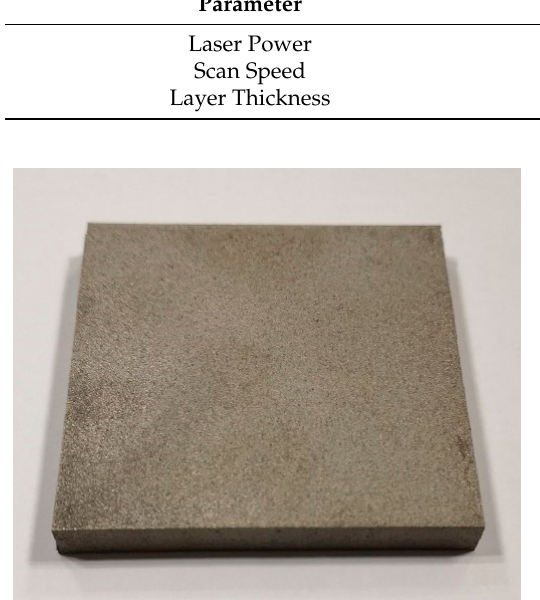
Figure 2. Additively manufactured TC-4 specimens.